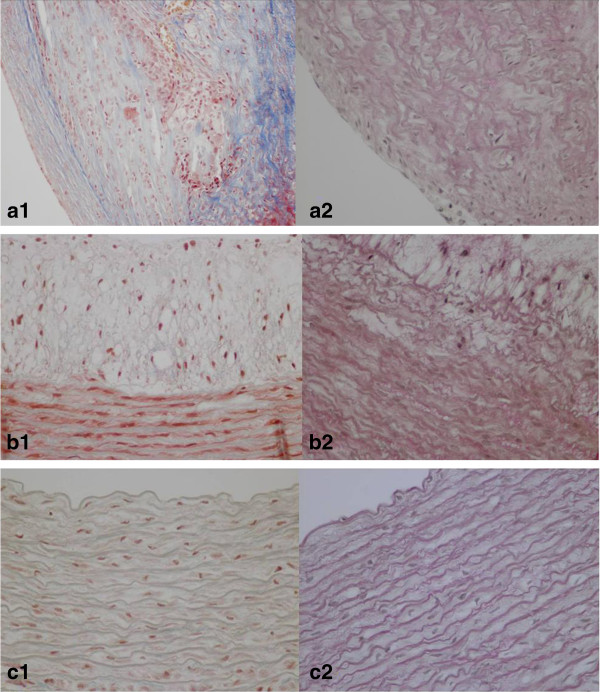
Masson’s trichrome and Van Gieson staining in descending thoracic aortas. a1. Great amount of collagen tissue deposition, and a2. Severe elastic fiber disruption and disorientation in balloon injured atherosclerotic thoracic aortas. b1. Slight collagen tissue increment and b2. Focal fragmentation and disorientation of elastic tissue in non-injured atherosclerotic thoracic aortas. c1. Absence of fibrosis, and c2. normal elastic fiber orientation in control thoracic aortas.